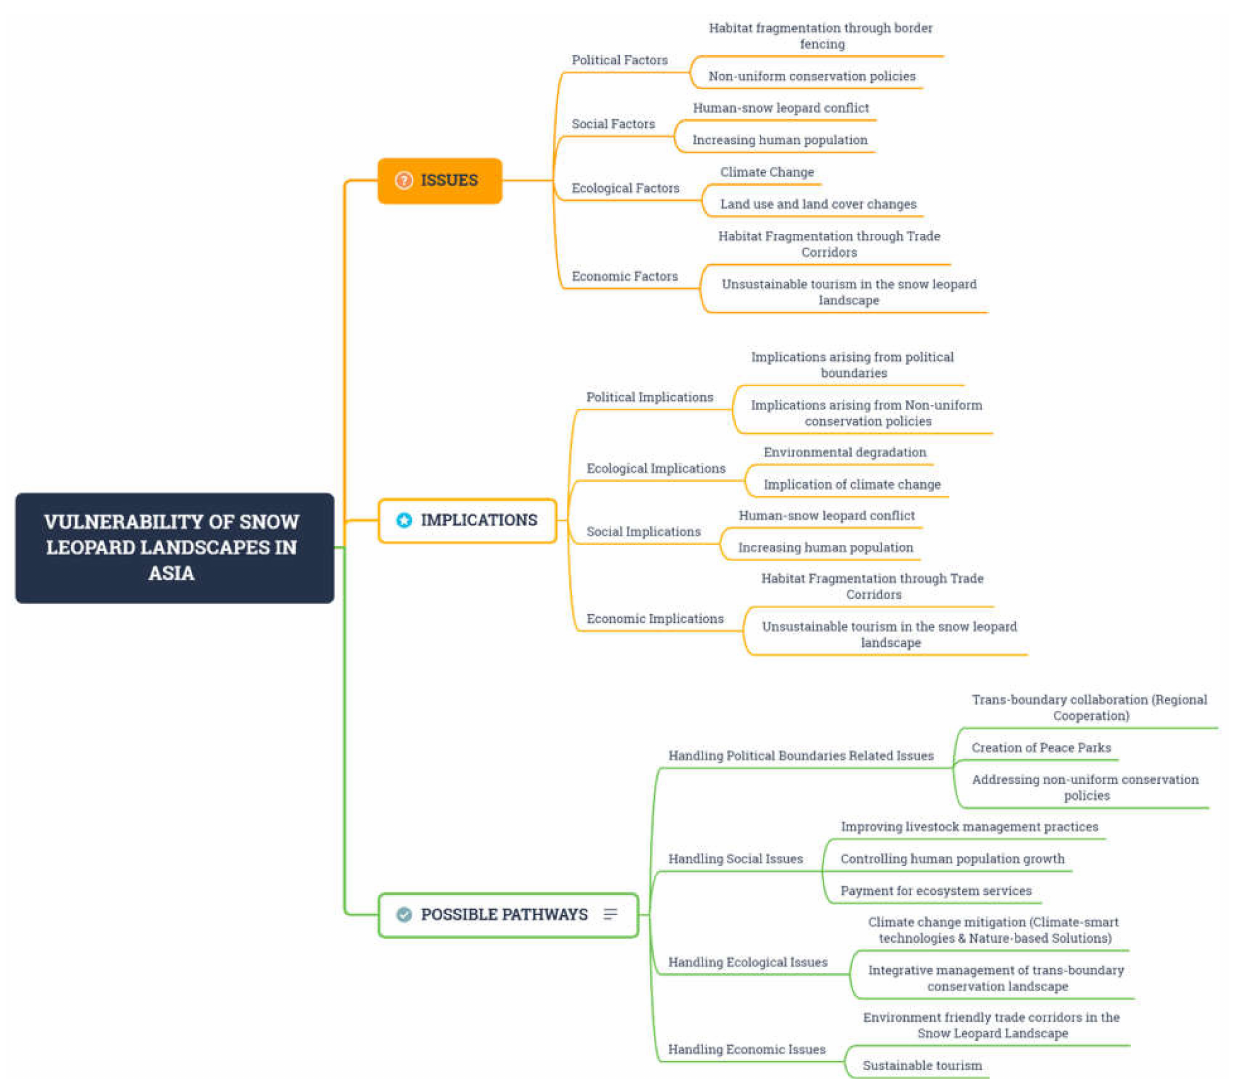
Figure 2. The workflow of the current review, displaying the vulnerability of snow leopard landscapes in the framework of issues, implications, and possible